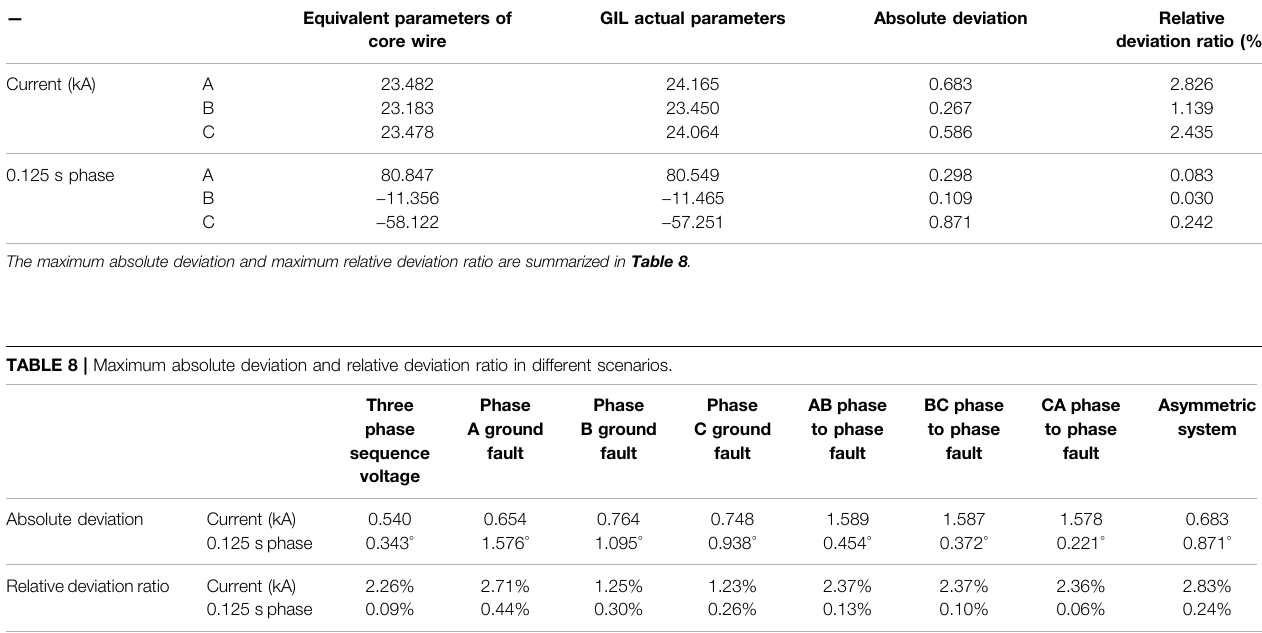
TABLE 7 | Comparison table of the three-phase currents on the N side between the equivalent parameter model of the core wire and the actual GIL parameter model in asymmetric system. Equivalent parameters of core wire